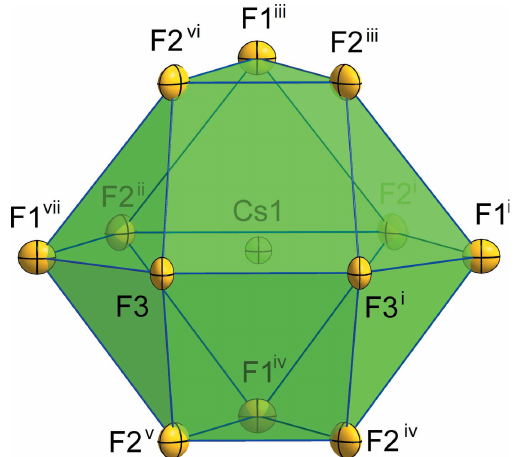
Figure 1 The anticuboctahedron around the caesium cation. Displacement ellipsoids are shown at the 70% probability level. [Symmetry codes: (i) (cid:2) x + 1, (cid:2) y + 1, (cid:2) z + 1; (ii) x , y , (cid:2) z + 1; (iii) x + 1 y + 1 , z + 1 ; (v) (cid:2) x + 1 , (cid:2) y + 1 , z + 1 ; (vi) (cid:2) x + 3 2 2 2 2 2 (cid:2) y , (cid:2) z +